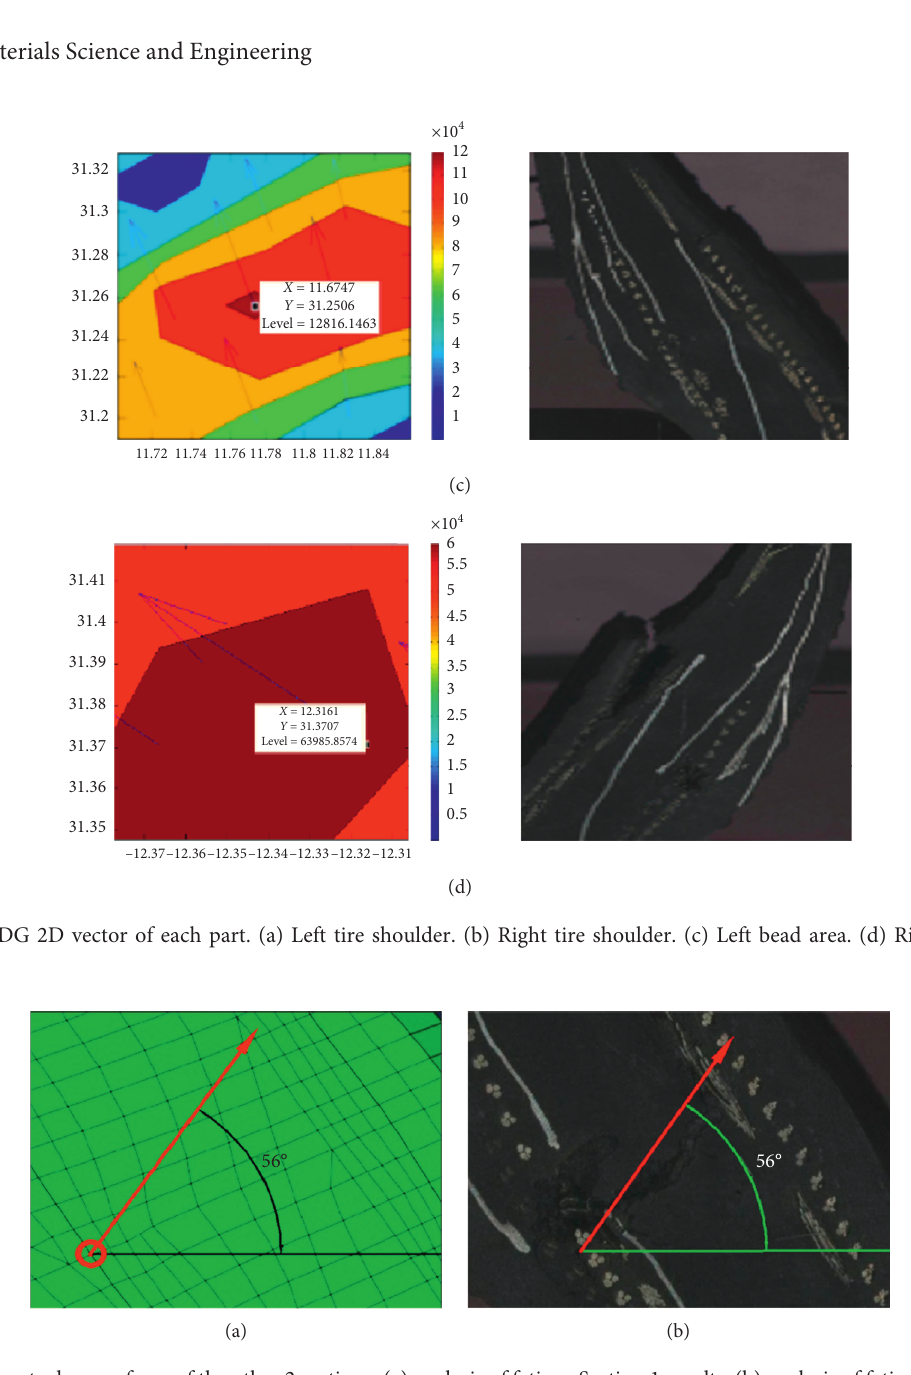
Figure 7: The concrete damage form of the other 2 sections: (a) analysis of fatigue Section 1 results; (b) analysis of fatigue Section 2 results.